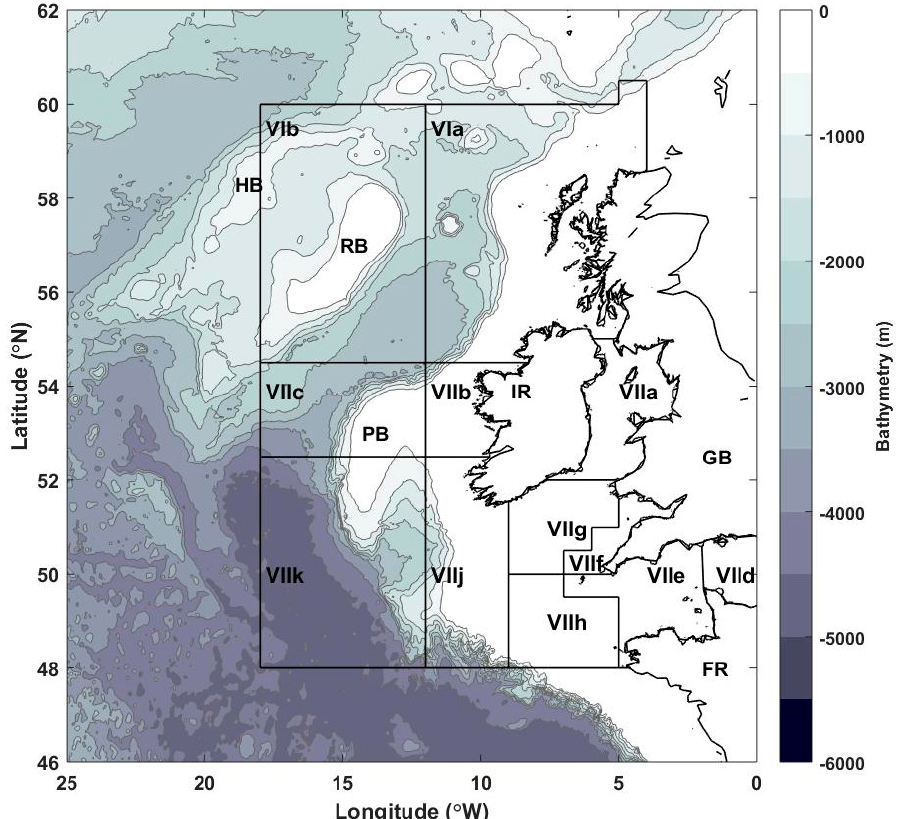
Figure 1. Study area, where Roman numerals denote ICES divisions considered in this study. Letter abbreviations are as follows: IR-Ireland, GB—Great Britain, FR-France, PB-Porcupine Bank, RB- Rockall Bank, HB-Hatton Bank.